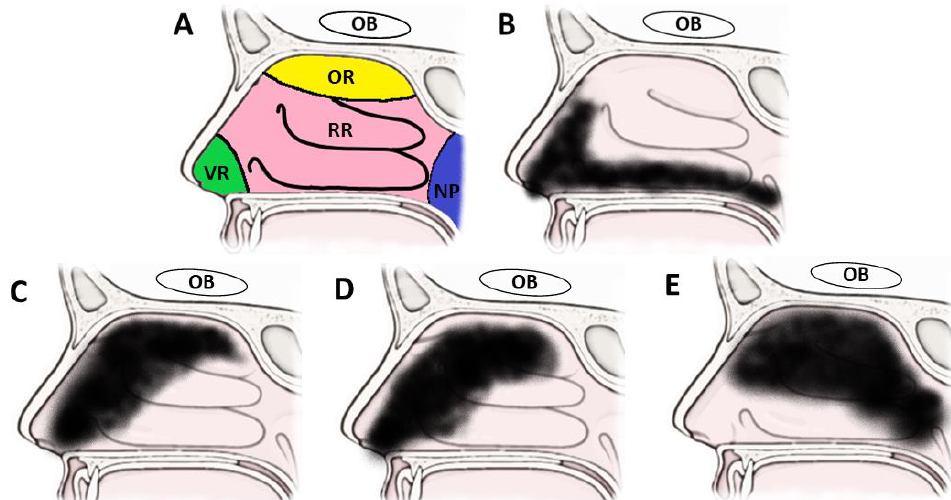
Figure 4. Estimation of deposition by nasal spray devices based on human in vivo studies. ( A ) regions of nasal cavity including the anterior vestibular (VR), superior olfactory (OR) and large respiratory regions (RR), as well as the posterior oropharynx (NP). The olfactory nerve is in the olfactory region and goes to the olfactory bulb (OB), while the trigeminal nerve is found in the respiratory regions and goes to the pons. ( B ) distribution of traditional nasal sprays is limited to vestibular and lower respiratory regions. ( C – E ) distributions of Vianase ™ ( C ), Optinose Opt-Powder ™ ( D ), and Impel POD ® ( E ) all demonstrate significantly more dose reaching the olfactory region.